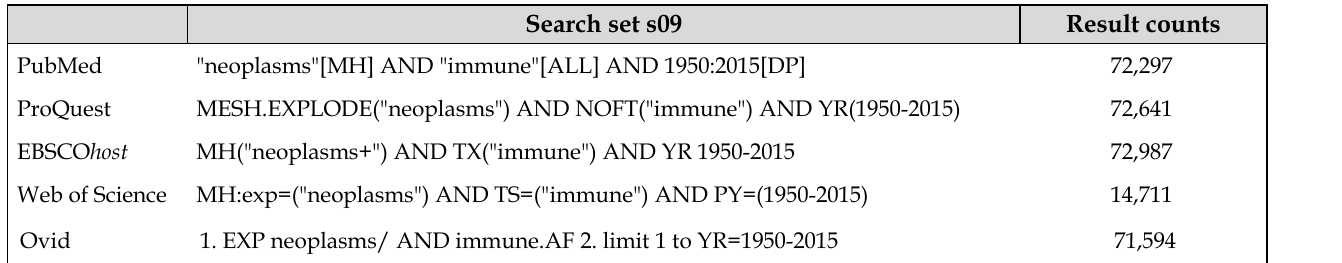
Table 1 Example search queries and results for search set s09